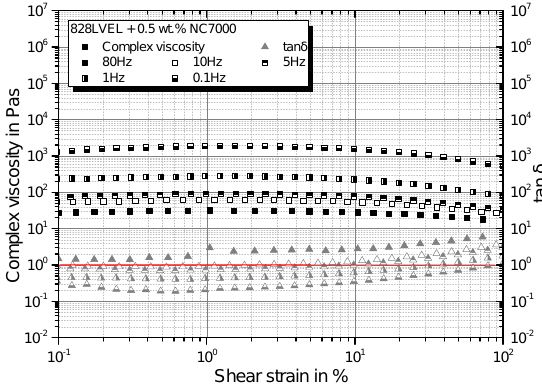
Figure 6. Shear strain dependency of complex viscosity and tan δ .